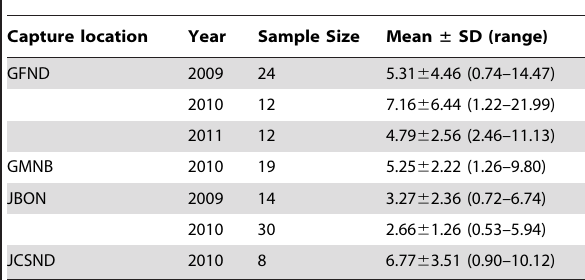
Table 1. Mean first primary feather (P1) mercury concentrations (ppm fw) for Nelson’s Sparrows captured at four locations (refer to Fig. 1) over three breeding